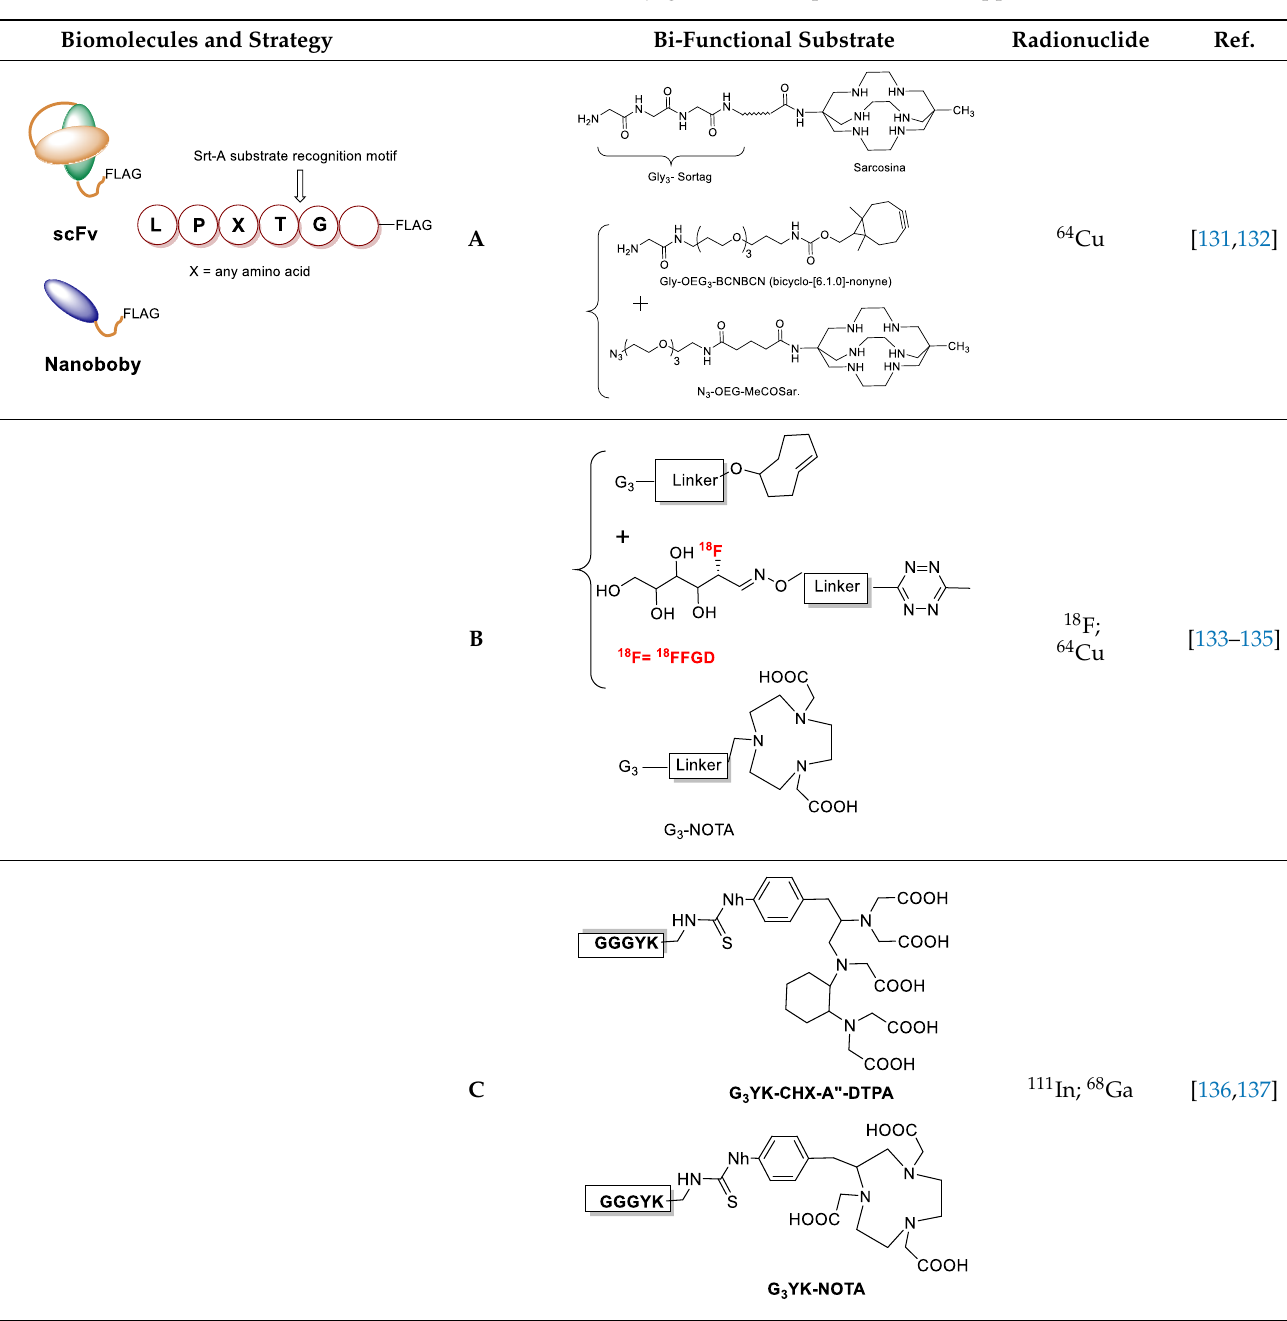
Table 6. Overview of Sortase A mediated conjugation in radiopharmaceutical applications. Biomolecules and Strategy